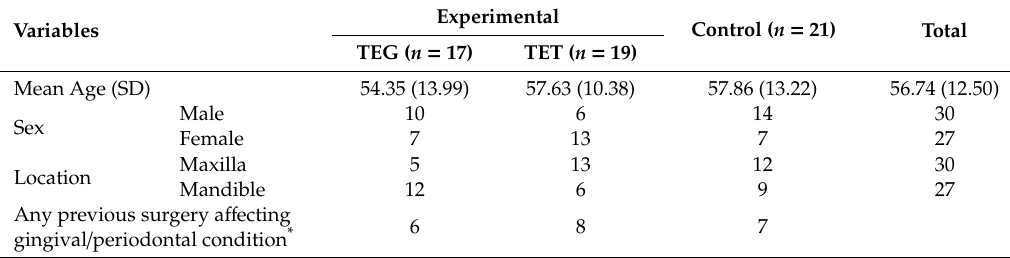
Table 1. Descriptive statistics: age, sex, and treatment location of study